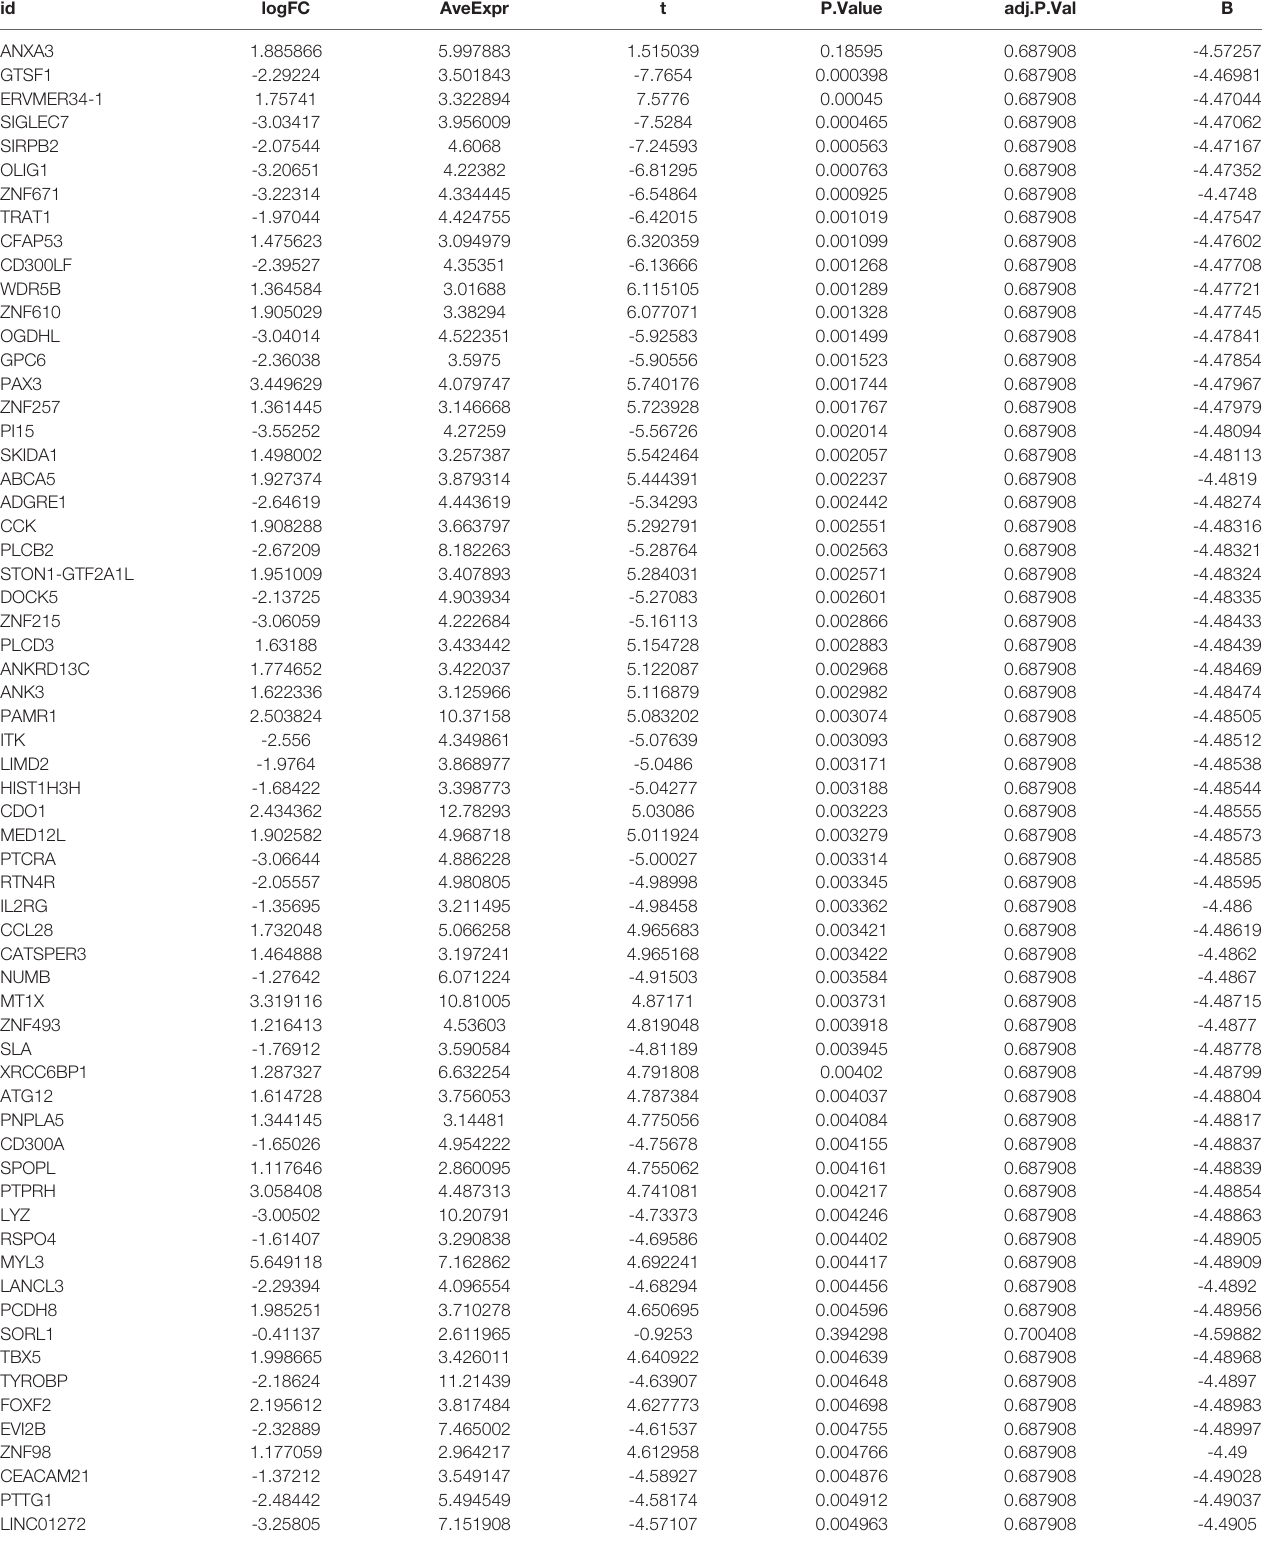
TABLE 1 | List of differentially expressed genes in the GEO